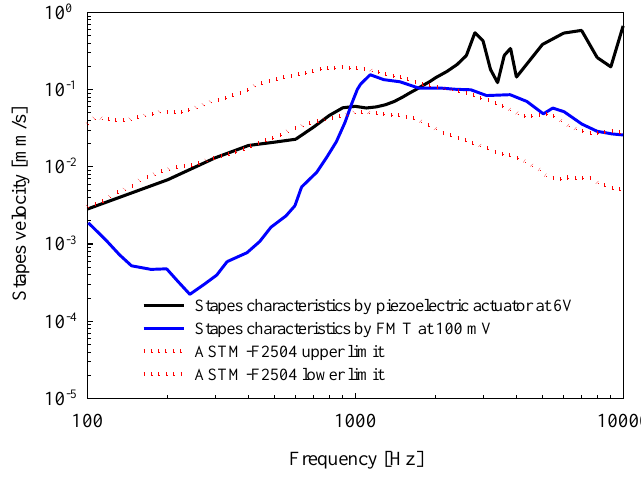
Figure 9. Comparison of vibrational response upon RW stimulation between the piezoelectric actuator (black solid line) and the floating mass transducer (FMT) (blue solid line, [13]).